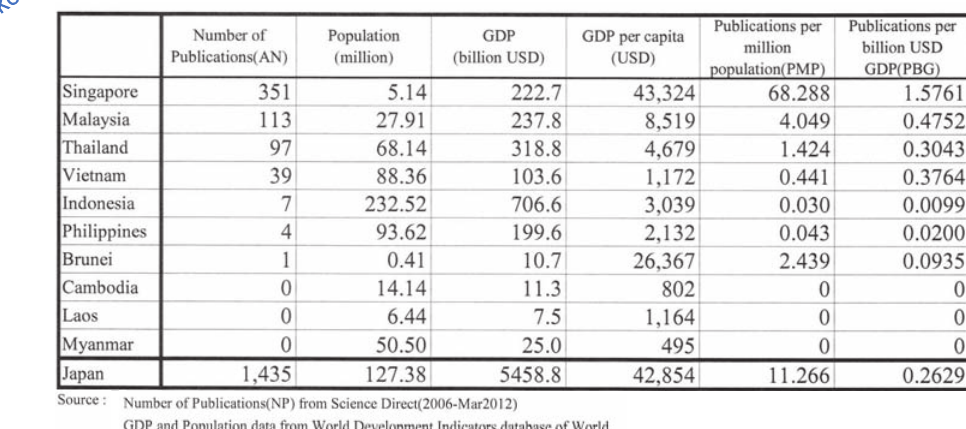
Table 1 Relevant Statistics of Publications on Nanoparticle